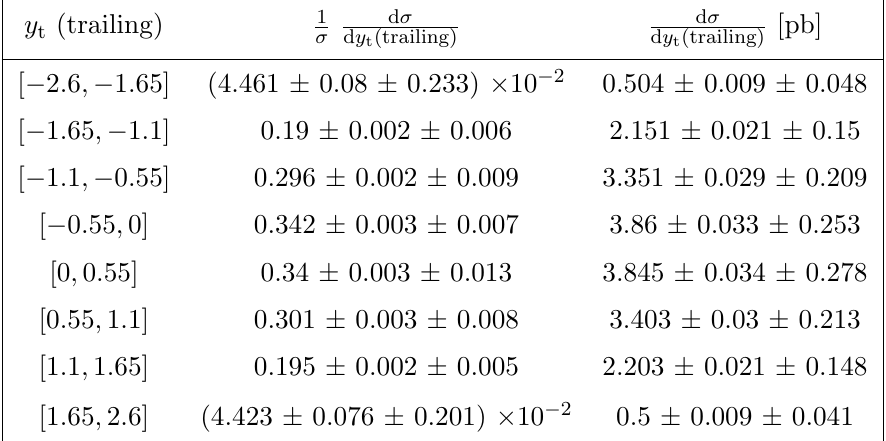
Table 23 . The measured di(cid:11)erential cross section and bin boundaries for each bin of the normalized and absolute measurements of the tt di(cid:11)erential cross section at particle level in the (cid:12)ducial phase space as a function of y t (trailing) are